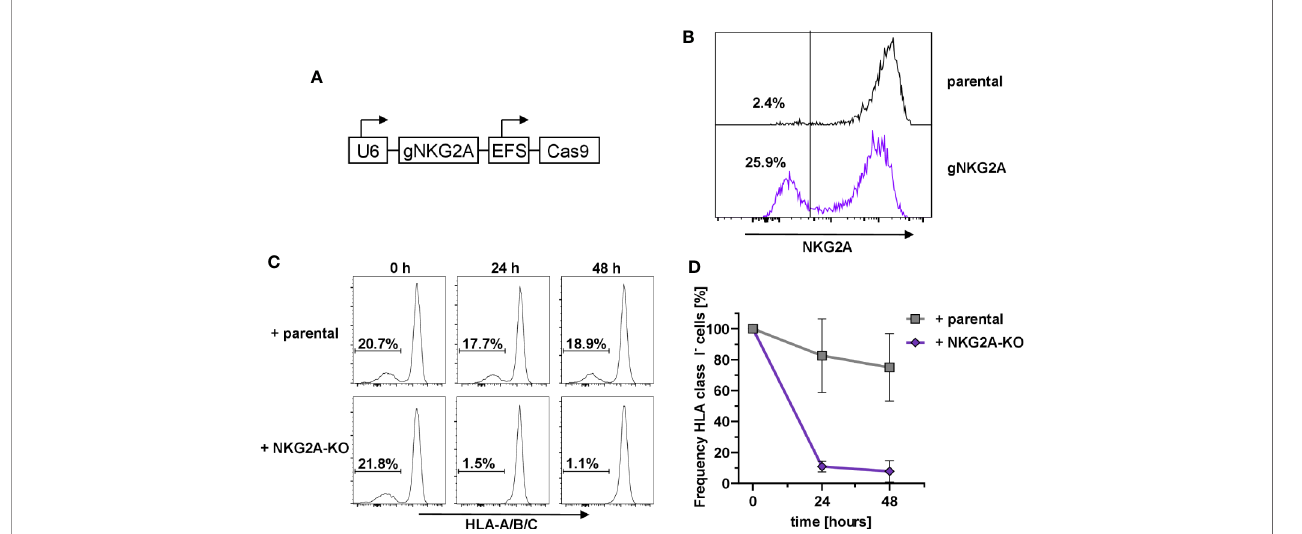
FIGURE 2 | Dependency on NKG2A expression for sc-HLA-E-mediated protection from NK cell fratricide (A) Outline of the lentiviral expression cassettes used for CRISPR/Cas9 mediated NKG2A-knockout. (B) Transduction with Cas9 and gNKG2A led to abrogation of NKG2A surface expression in primary NK cells 7 days post transduction. (C) Representative histograms showing the frequency of sc-HLA-E/B2M-KO NK cells in presence of B2M-competent sc-HLA-E NK cells upon addition of parental cells (upper panel) or NKG2A-KO NK cells (lower panel) at different time points. (D) Quanti fi cation of changes in sc-HLA-E/B2M-KO NK cell frequencies relative to the time point (0 h) when parental or NKG2A-KO NK cells were added. Statistical analysis was performed by two-way ANOVA with Geisser- Greenhouse correction ( e = 0.6972) for repeated measures and Holm-Sidak testing for multiple comparisons between each time point within both groups. For the samples containing NKG2A-KO NK cells, the decrease in frequency of HLA class I − was statistically signi fi cant at both time points (mean ± SD; n =